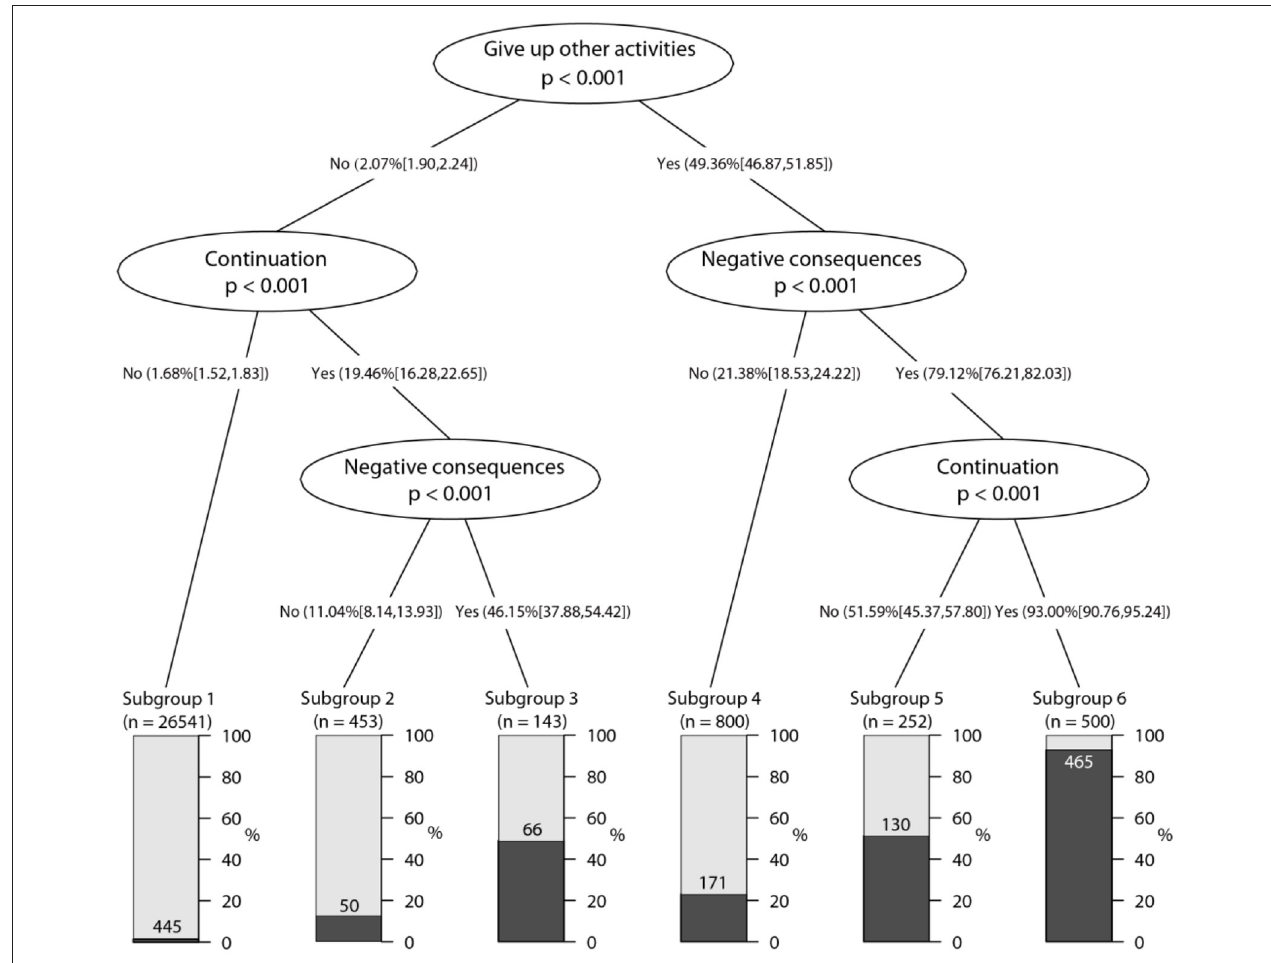
FIGURE 1 | Conditional inference tree plot predicting DSM-5 IGD by diagnostic criteria, age, gender and gaming time ( n =